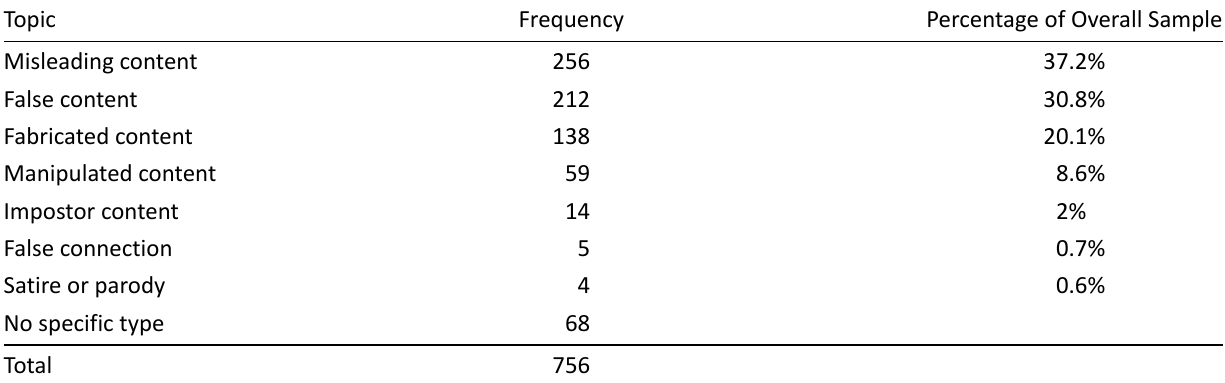
Table 6. Type of information disorder.